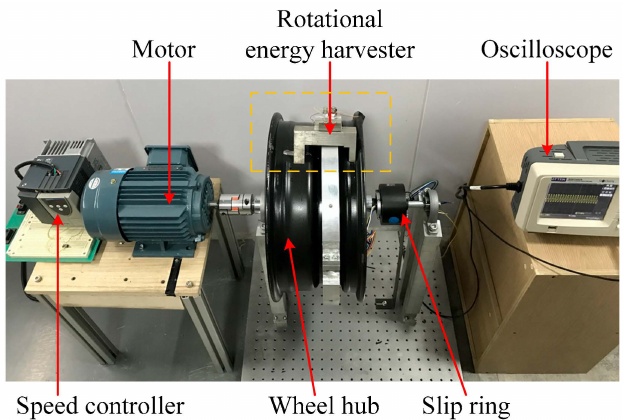
Figure 8. Experimental setup to test the energy harvester.